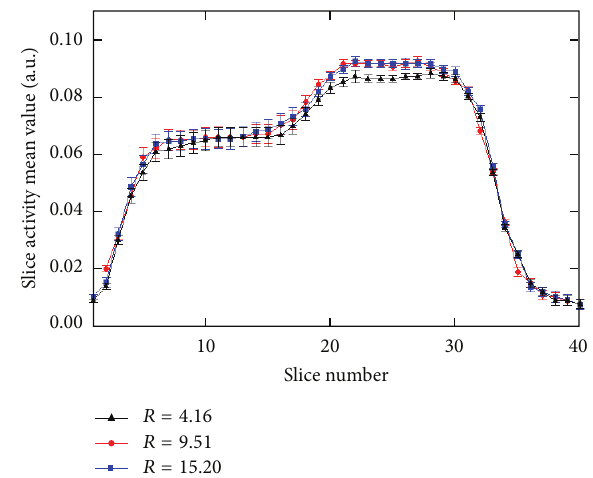
Figure 3: The average activity for reconstructed 40 slices of NEMA NU4-2008phantomfilledwith 99 m Tc-pertechnetatesolutionhaving 𝑅 = 4.16 , 𝑅 = 9.51 , and 𝑅 = 15.2